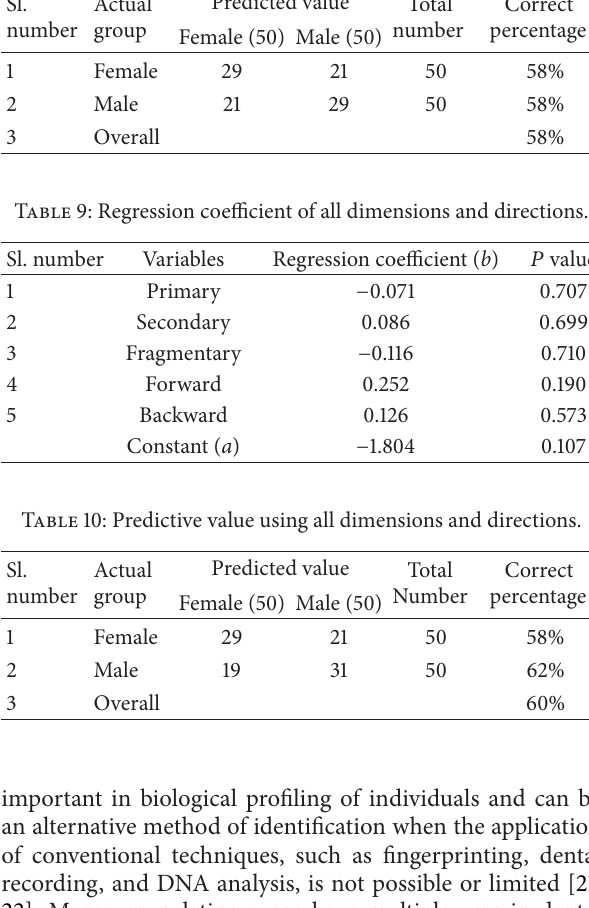
Table 8: Predictive value using all shapes. Sl.